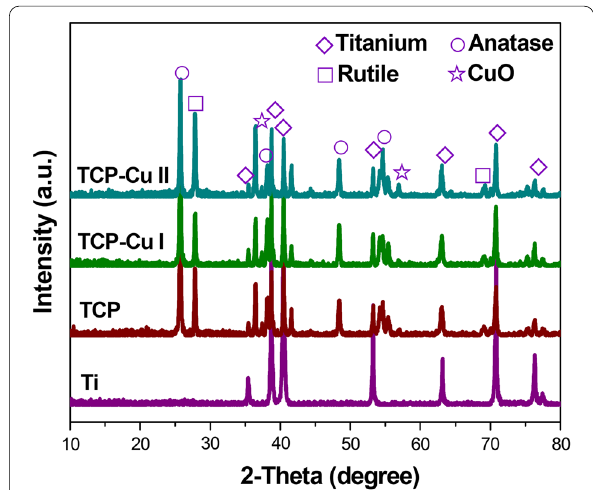
Fig. 3 XRD patterns of Ti, TCP, TCP CuI and TCP CuII